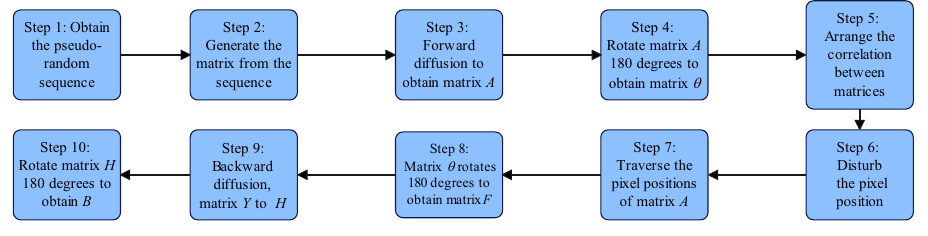
Figure 13. Encryption process